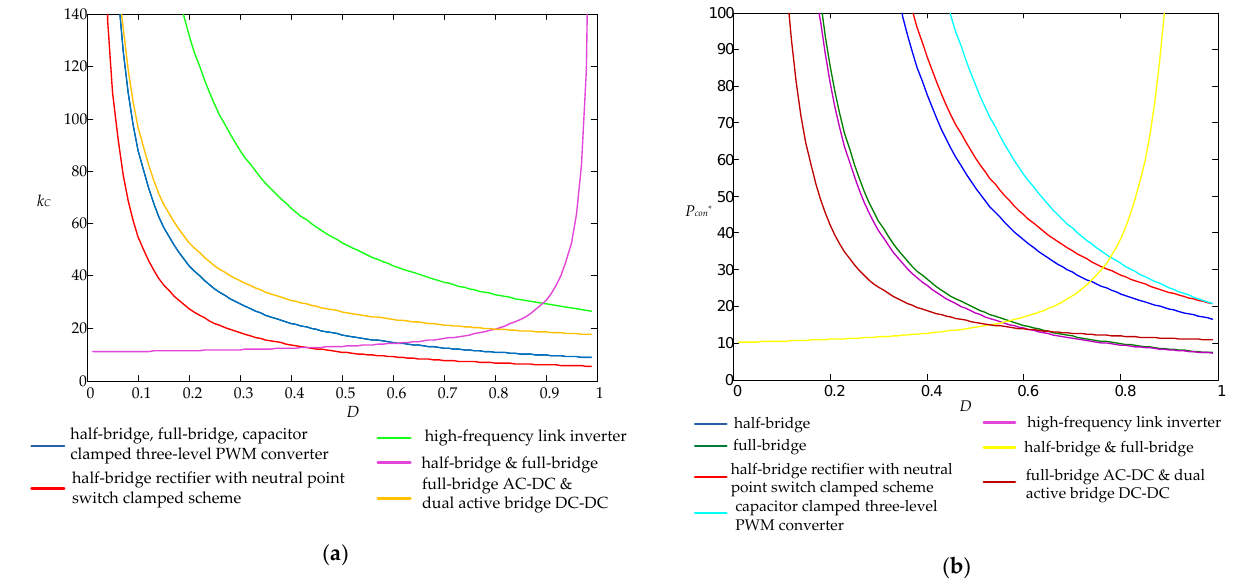
Figure 17. The parameters for DC – AC applications ( a ) Cost factor k C ; ( b ) normalized power loss P con * in DC – AC energy storage converters.